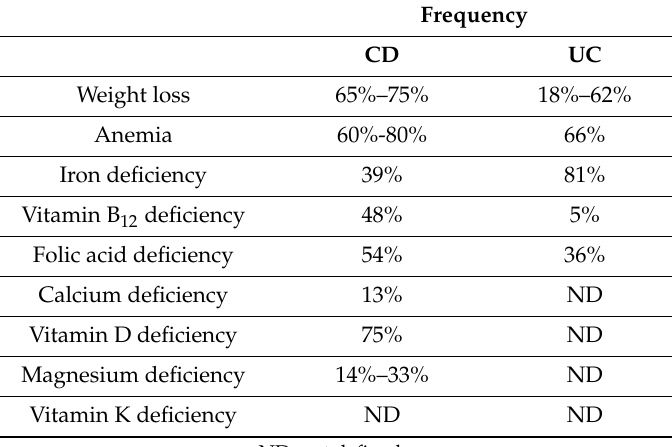
Table 1. Frequency of nutritional deficiencies in Crohn’s disease (CD) and ulcerative colitis( UC) patients (adapted from Lochs)